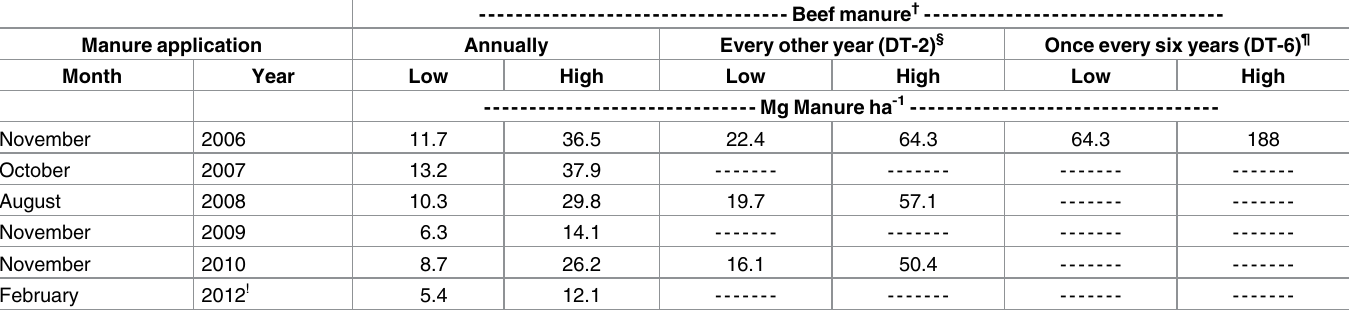
Table 2. The amount of manure application (Mg ha -1 ) since the initiation of the study from 2006 to 2013 growing seasons. Manurewas added close to the fall season anticipating the subsequence year crop except for 2012 where the manure was added in February of that year. Manure application